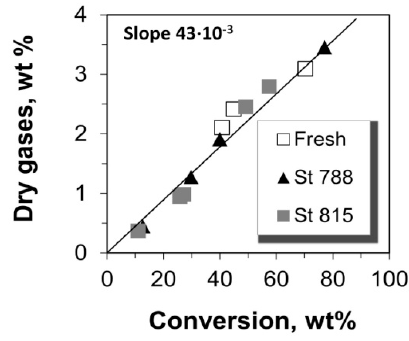
Figure 6. Yield of total dry gases versus the conversion of n-C 12 .